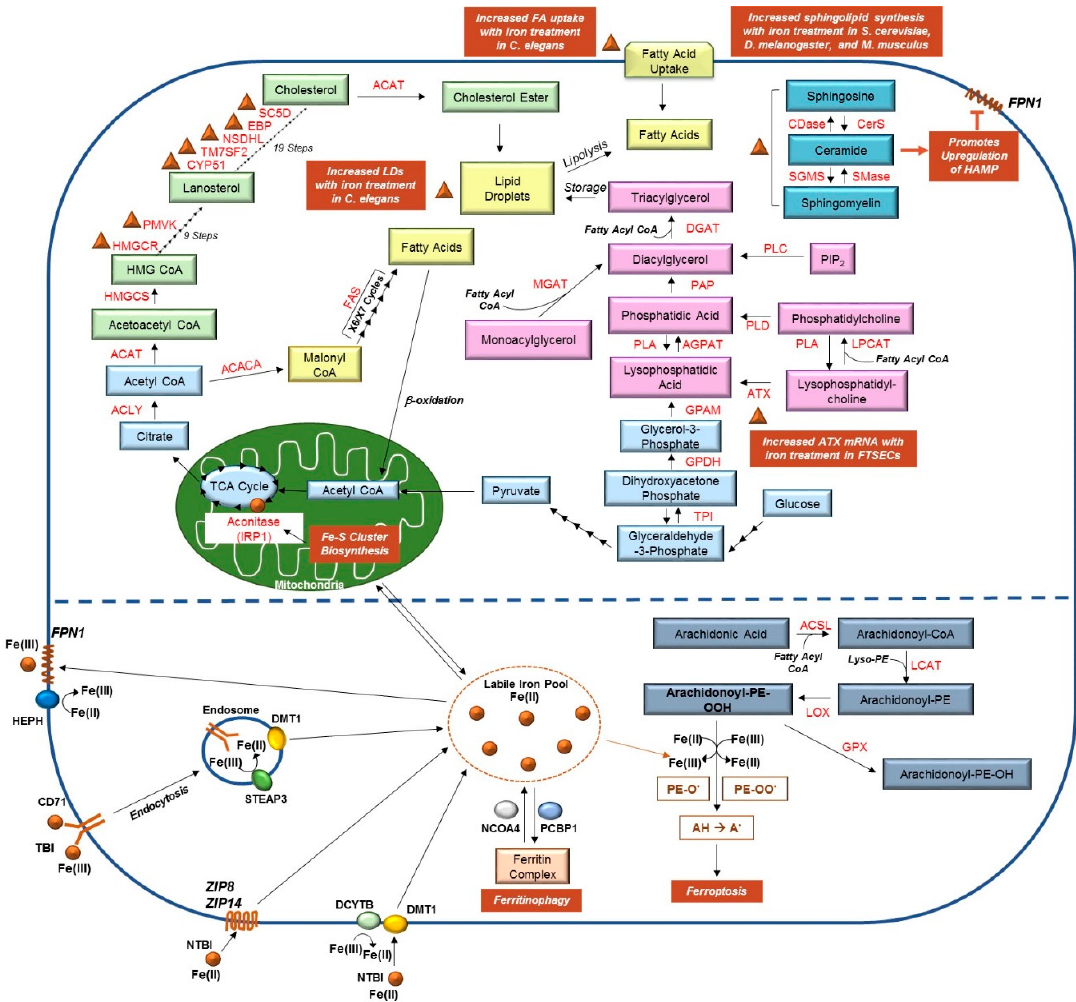
Figure 1. Links between Lipid and Iron Metabolic Pathways . ( Top ) Pyruvate, a product of glycolysis, is converted to acetyl-CoA in the mitochondria. Acetyl-CoA feeds into the Krebs (TCA) cycle, illustrated in light blue, to generate citrate; the conversion of citrate to isocitrate is mediated by the enzyme aconitase and requires binding to Fe-S clusters (as indicated by the brown circle). Citrate can also be transported from the mitochondria to the cytosolic compartment where it is used to generate acetyl-CoA; this molecule can then feed into either the cholesterol biosynthetic pathway (green) or the fatty acid synthesis pathway (yellow). Elevated liver iron concentrations correlated with increased mRNA expression of several genes involved in cholesterol biosynthesis (namely, HMGCR, PMVK, CYP51, TM7SF2, NSDHL, EBP, and SC5D), as indicated with brown triangles (see Section 2.1). Exogenous fatty acids can also be imported into the cell; together, fatty acids, triacylglycerides, and cholesterol esters are essential components of lipid droplets. As detailed in Section 2.4, iron can promote both fatty acid import and lipid droplet formation. Synthesis of triacylglycerides, as well as phospholipids (and their modification), are presented in pink, whereas the sphingolipid metabolic pathway is displayed in dark blue. Iron can promote the production of ceramide (indicated with a brown triangle), and in turn induces HAMP expression, which negatively regulates FPN1 (refer to Section 2.2). Furthermore, our own unpublished work suggests iron treatment in human fallopian tube secretory epithelial cells (FTSECs) increases mRNA expression of autotaxin (ATX), which is involved in generating lysophosphatidic acid (see Section 2.5). ( Bottom ) TBI can be imported via